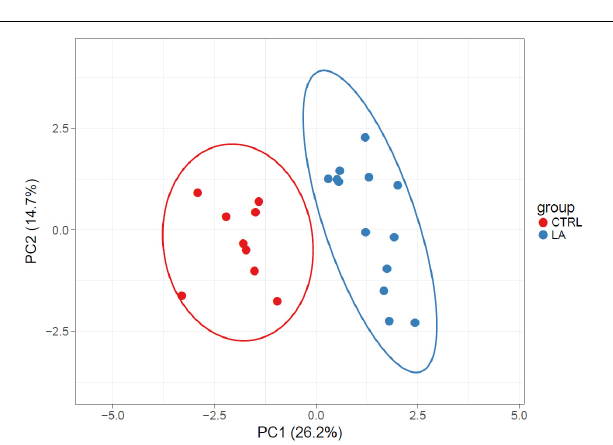
FIGURE 4 | Beta diversity of analyzed samples represented by significantly altered ( p < 0.05) OTUs in elderly athletes and the control group visualized by PCA. SVD with imputation is used to calculate principal components. X and Y axes show principal component 1 and principal component 2 that explain 26.2 and 14.7% of the total variance, respectively. Prediction ellipses are such that with a probability of 0.95, a new observation from the same group will fall inside the ellipse ( N = 22 data